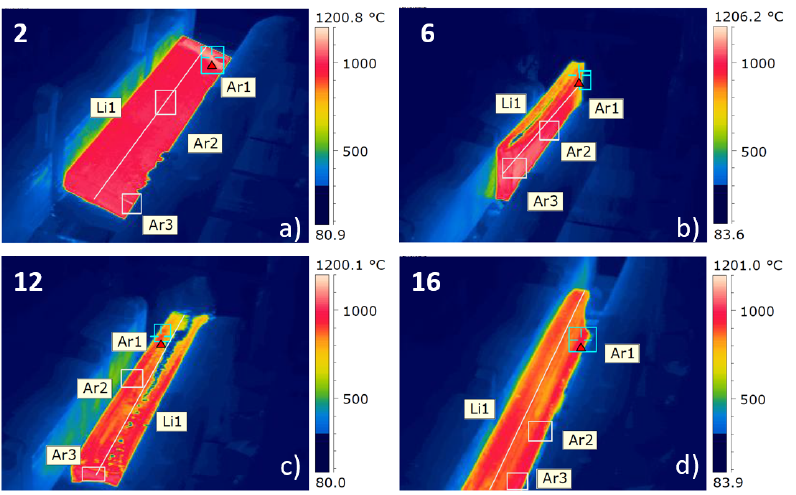
Figure 6. Representative thermographic images taken during the hot rolling process: ( a ) pass 2; ( b ) pass 6; ( c ) pass 12; ( d ) pass 16. Table 4. Average temperature used to feed the numerical